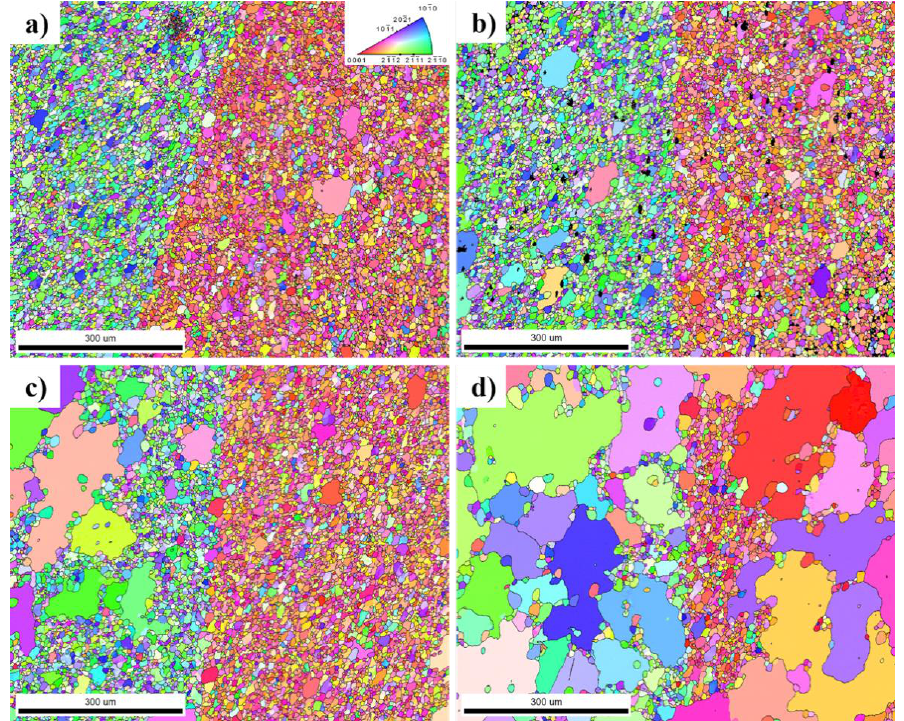
Figure 5. IPF maps ( ∥ <110>) outlining different microstructures in the weld seam after heat treatment at 475 °C: ( a ) as-extruded, ( b ) after 400 s, ( c ) after 1200 s, and ( d ) 3600 s, ED parallel to the weld line, ER = 8:1.